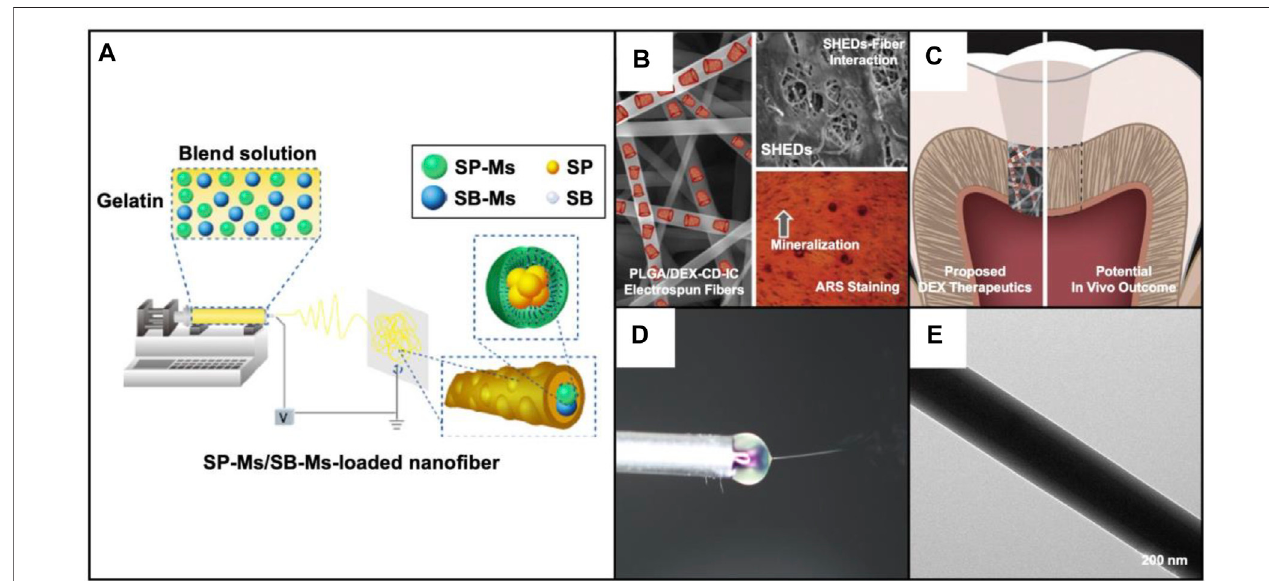
FIGURE2|(A) Schematic illustration showing thefabricationofthedual-drugdelivery system. SP600125 and SB203580 were separately loaded intothe PEG-b- PCL micelles, and then the micelles were blended with gelatin solution for electrospinning. Reproduced with permission (Wang Y. et al., 2019). Copyright 2019, Dovepress. (B) SEMimagetogetherwithaschematicillustration showingthePLGA fi bers loaded withdexamethasoneand cyclodextrininclusioncomplex(PLGA/DEX- CD-IC) (left); SEM image showing the single-cell suspensions isolated from human pulp tissues seeded on the fi bers (right top); Alizarin red staining showing the effectofDEX inducedmineralization (rightbottom). Reproduced withpermission(Daghreryet al.,2020).Copyright2020,Elsevier. (C) Schematicillustration showingthe proposed therapeutics with the PLGA/DEX-CD-IC fi bers and the potential in vivo outcome. Reproduced with permission (Daghrery et al., 2020). Copyright 2020, Elsevier. (D) Photograph of the core-shell jet at the end of spinning needle. Reproduced with permission (Liu et al., 2020). Copyright 2020, Elsevier. (E) TEM image of core-shell nano fi bers with BMP-2 aqueous solution as the core while the blend of SP600125 and gelatin as the shell. Reproduced with permission (Liu et al.,